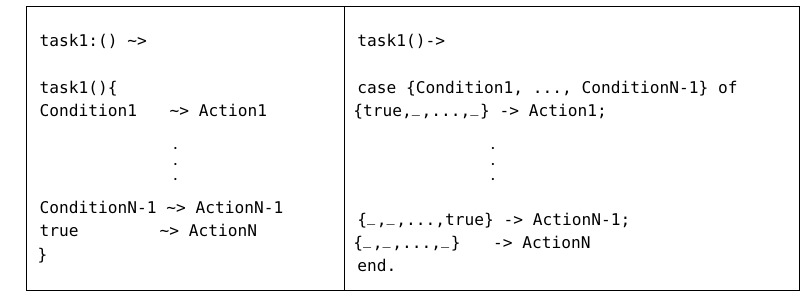
Table 3. From TeleoR goal (left) to Erlang function (right).